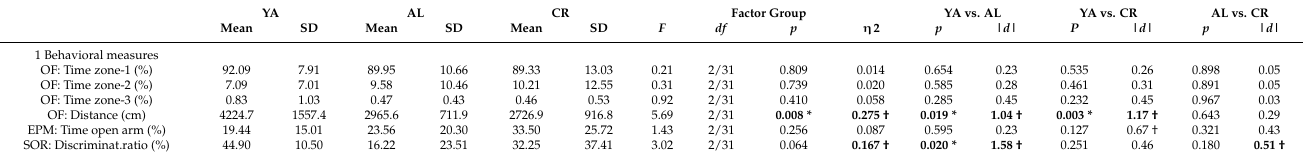
Table 1. Behavioural results obtained and assessed by one-way ANOVA.